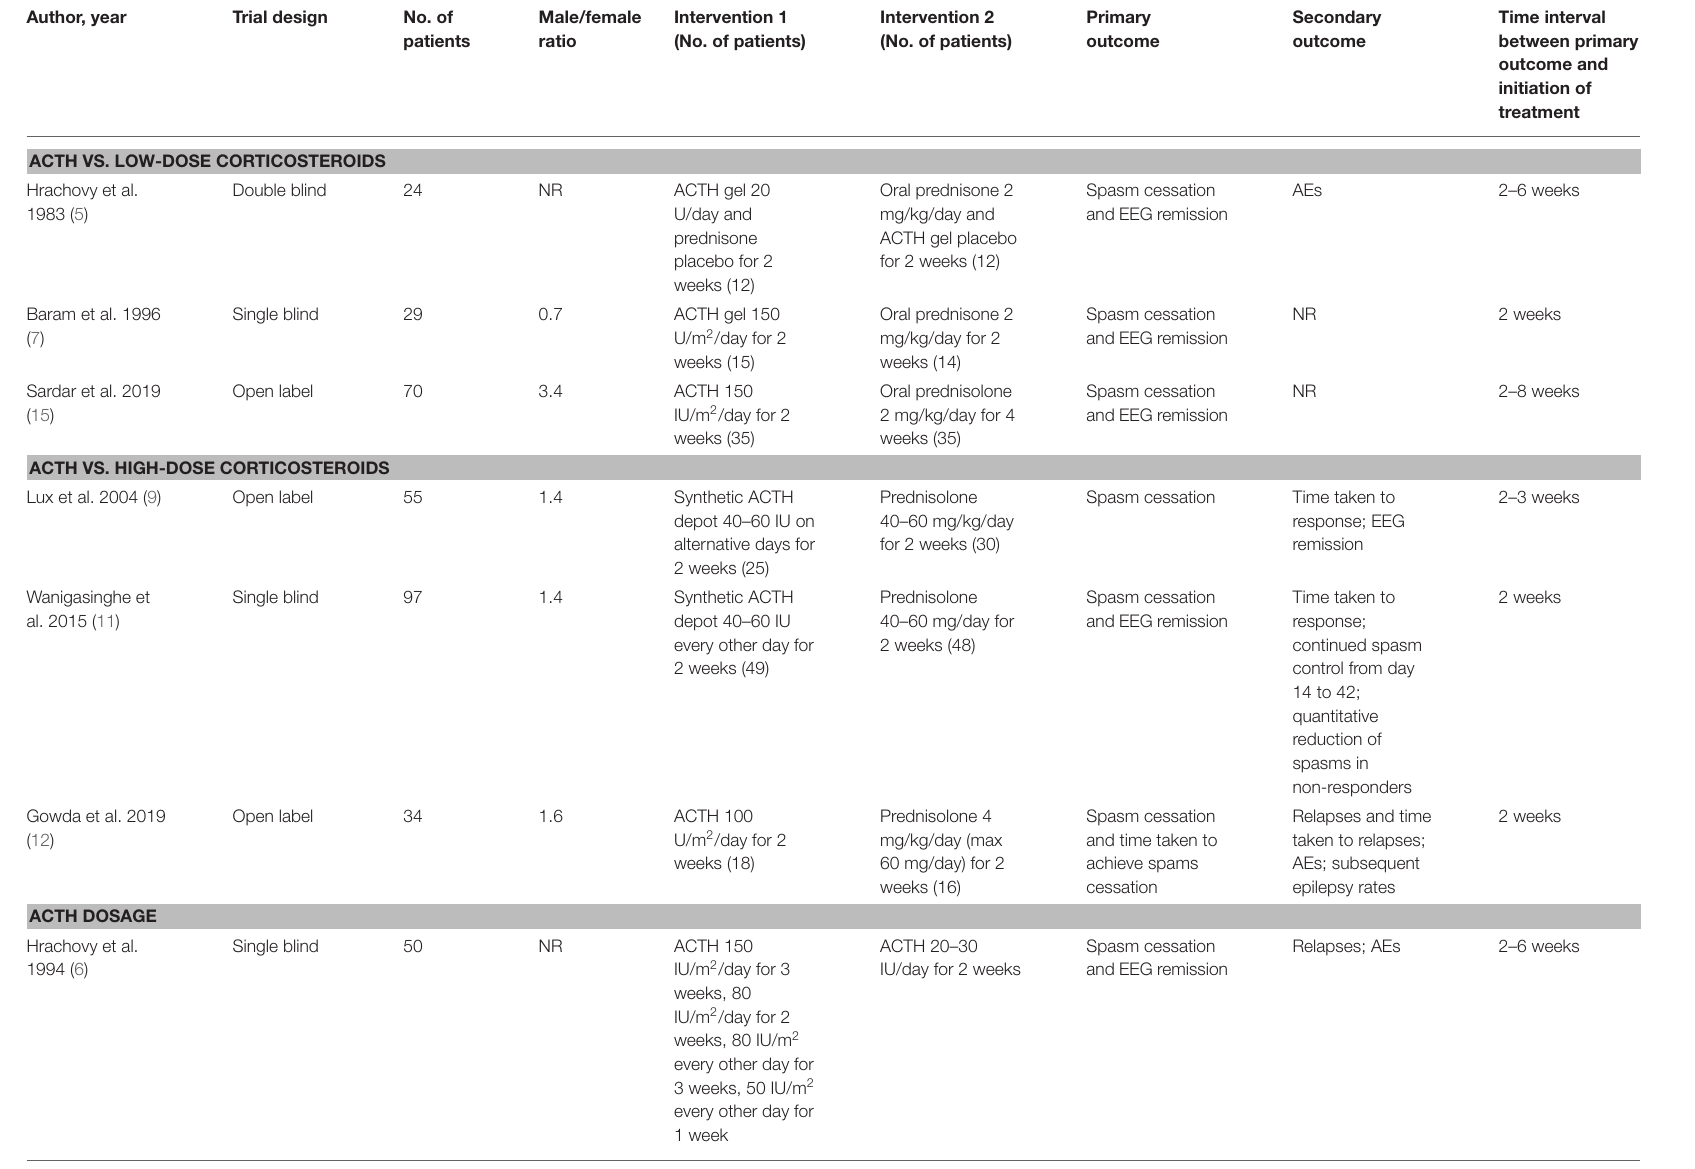
TABLE 1 | The characteristics included randomized controlled trials